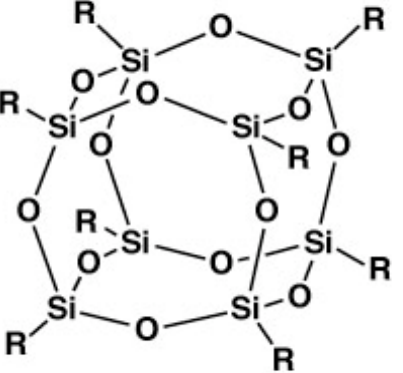
Figure 1. Molecular structure of polyhedral ologomeric silsesquioxane